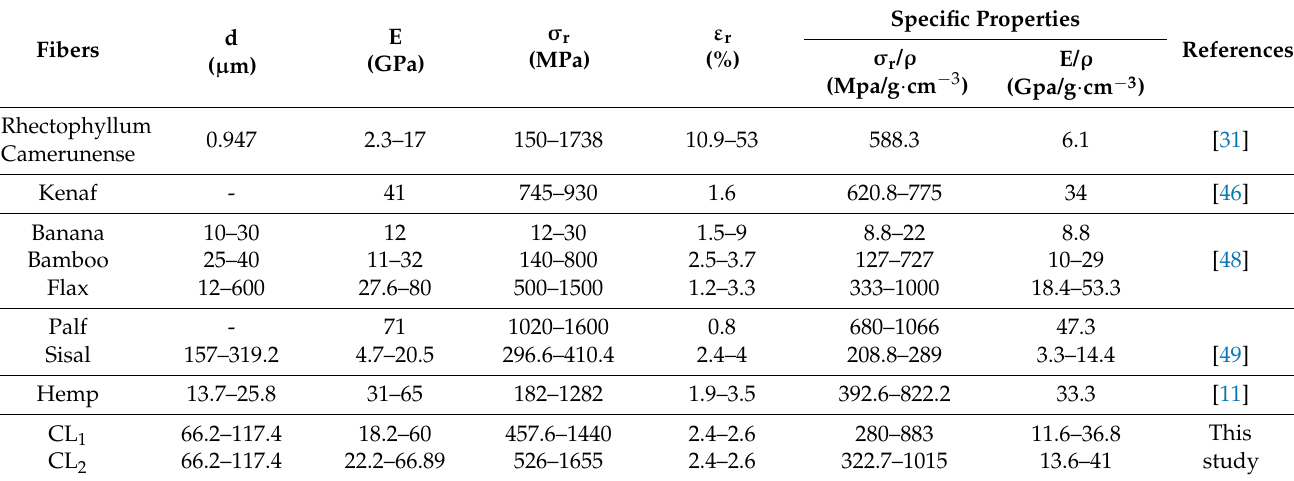
Table 2. Comparison of properties of CL fibers to others plant fibers.